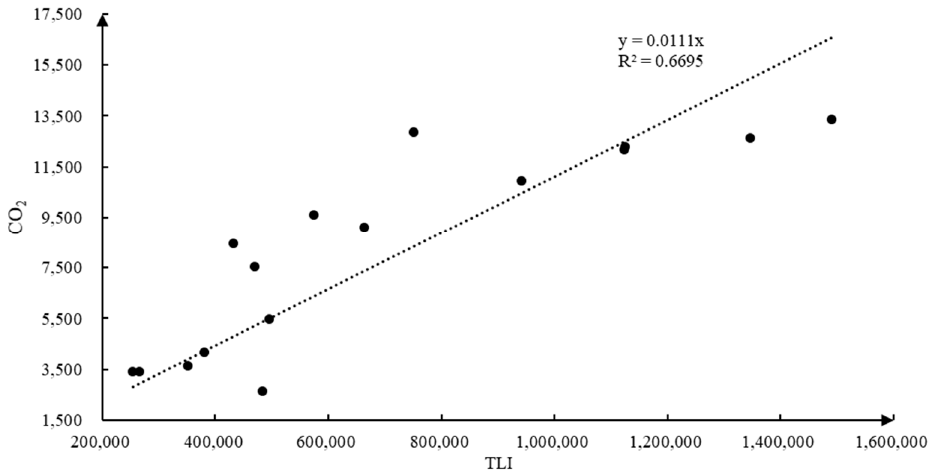
Figure 2. Relationship between CO 2 and TLI .